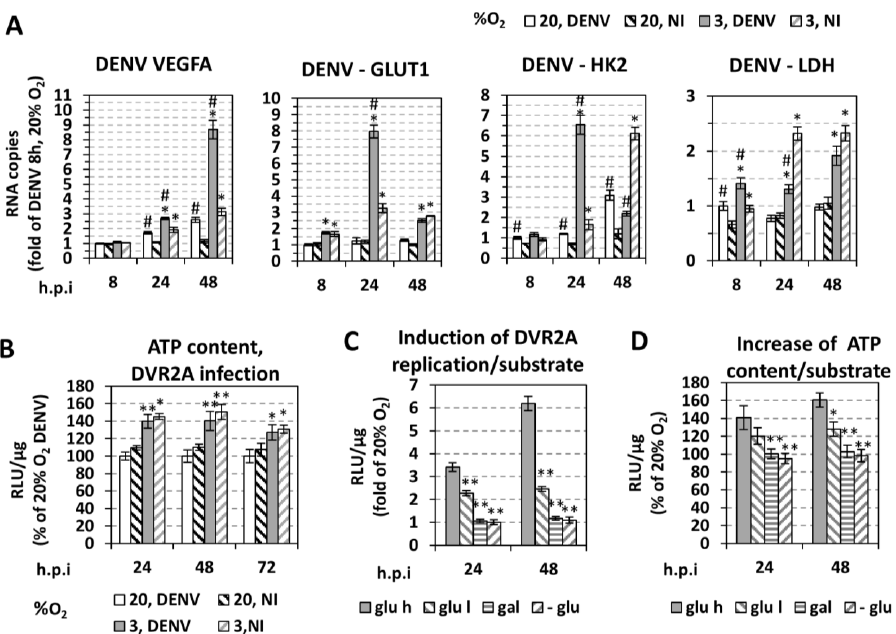
Figure 4. ( A , B ) Hypoxia induces transcriptomic and metabolic reprogramming in DENV-infected cells. ( A ) RT-qPCR analysis of VEGFA, GLUT1, HK2, and LDH mRNA in DENV-infected (MOI = 0.5) or non-infected Huh7 cells incubated at the specified oxygen conditions and lysed at the indicated time points p.i. YWHAZ mRNA levels were used for normalization . Values obtained with infected cells at 20% O 2 and lysed 8 h.p.i. were set to one. Mean values from three independent experiments are presented. * p < 0.001 vs. 20% O 2 cells, # p < 0.01 vs. NI cells (Student’s t -test). ( B ) Intracellular ATP levels of Huh7 DVR2A-infected (MOI 0.1) and non-infected cells, incubated at the specified oxygen conditions. Cells were lysed at the indicated time points p.i. and intracellular ATP levels were expressed as RLU/ µ g of total protein amount. Values from cells cultured at 20% O 2 at each time-point were set to 100. * p < 0.01, ** p < 0.001 vs. 20% O 2 cells. ( C,D ) Association between glucose metabolism and low oxygen-mediated DENV replication enhancement. Fold difference between 3% and 20% O 2 of viral replication-derived luciferase activity ( C ) and intracellular ATP levels ( D ) in DVR2A-infected cells (MOI 0.01) incubated in culture media that differ in glucose concentration: high glucose (25 mM, glu h), low glucose (5.56 mM, glu l), galactose (10 mM, gal) instead of glucose or no glucose (-glu). Cells were lysed at the indicated time points p.i. In all panels, bars represent mean values from at least three independent experiments in triplicate. Error bars indicate standard deviations. * p < 0.001, ** p < 0.001 vs. glu h cells at 3% O 2